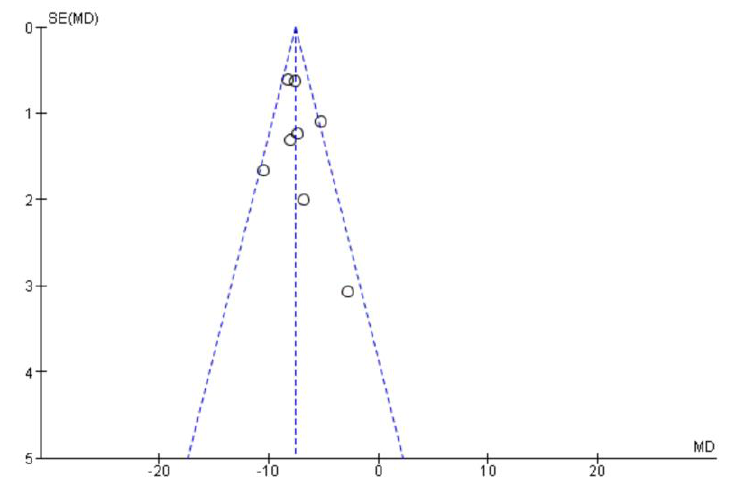
Figure 2. Funnel plot (publication bias).